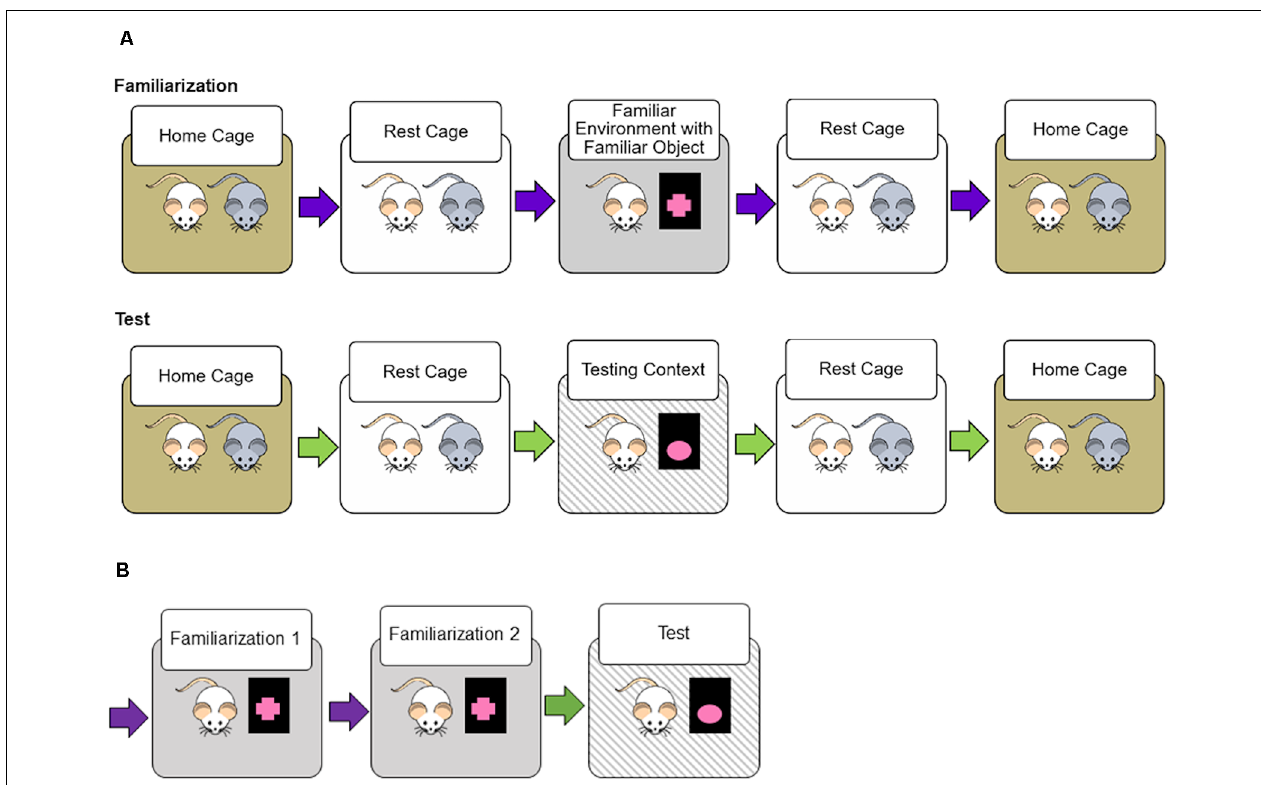
FIGURE 1 | Novel transportation procedure. (A) For two 10-min familiarization sessions rats were transported from their homecage to a rest environment with their cage mate. After a 5-min rest period, a single rat is transported to the familiarization context (familiar environment with a familiar object placed within). After the first rat in the pair has habituated for 5 min, the cage mate is then introduced to the familiarization context. Twenty-four hs after the second familiarization session the testing session occurs. Like before, both rats are removed from a homecage and placed in the same rest environment before entrance to the testing context. The testing context was either identical to the familiarization context, or a novel object, novel transportation cues, or both were introduced. (B) In each study, rats underwent two familiarization sessions spaced 24 h apart, followed by a 3-min testing session. In the short retention interval study, the delay between the second familiarization session was 1 h, for the long retention interval and anchored object studies the delay was 24 h. Different color arrows depict different transportation cues. All familiarization utilized familiar transportation